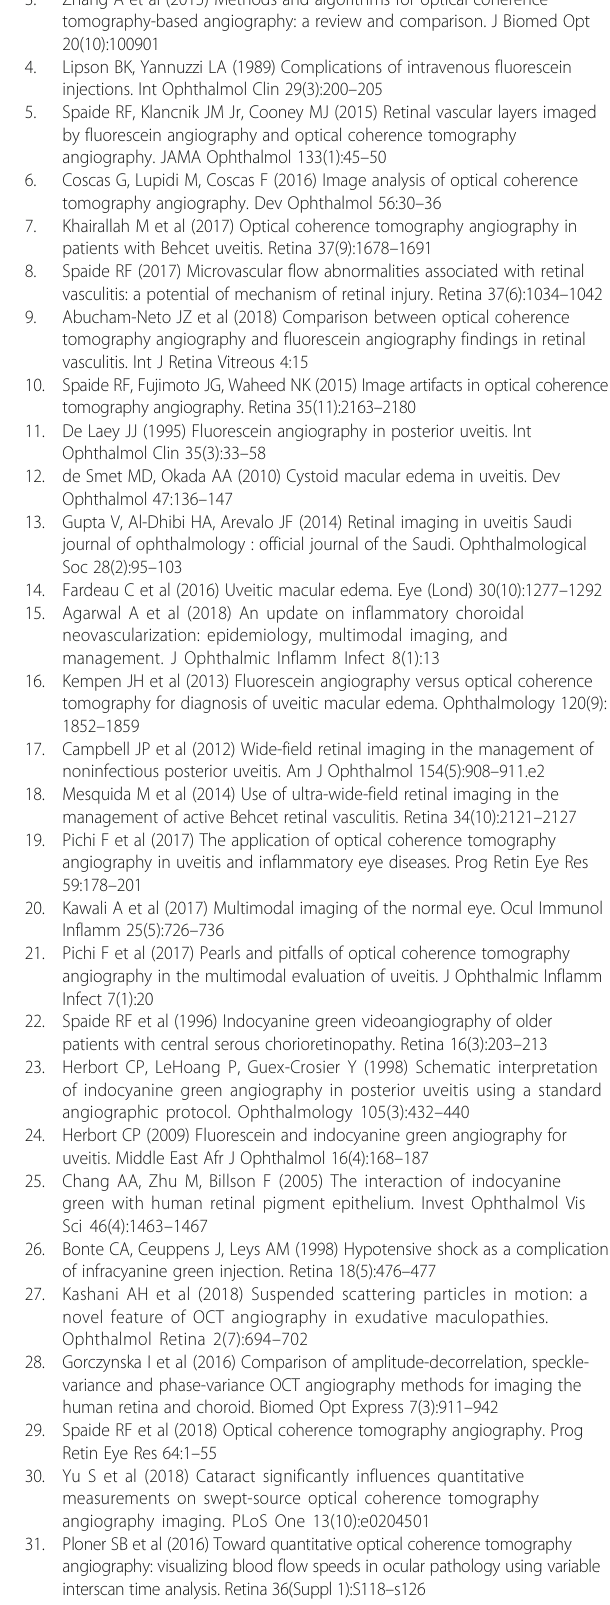
Abbreviations AMN: Acute macular neuroretinopathy; anti-VEGF: